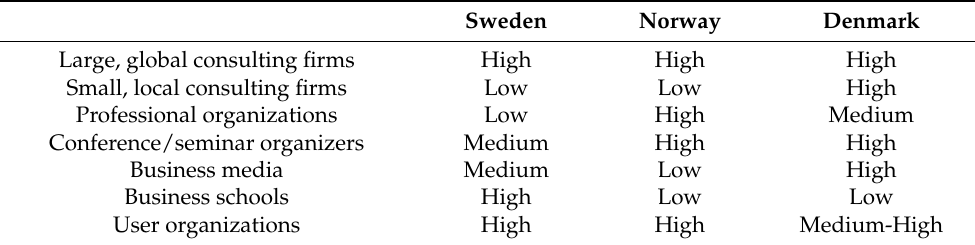
Table 2. Comparative analysis of the relative importance of different actors involved in the three